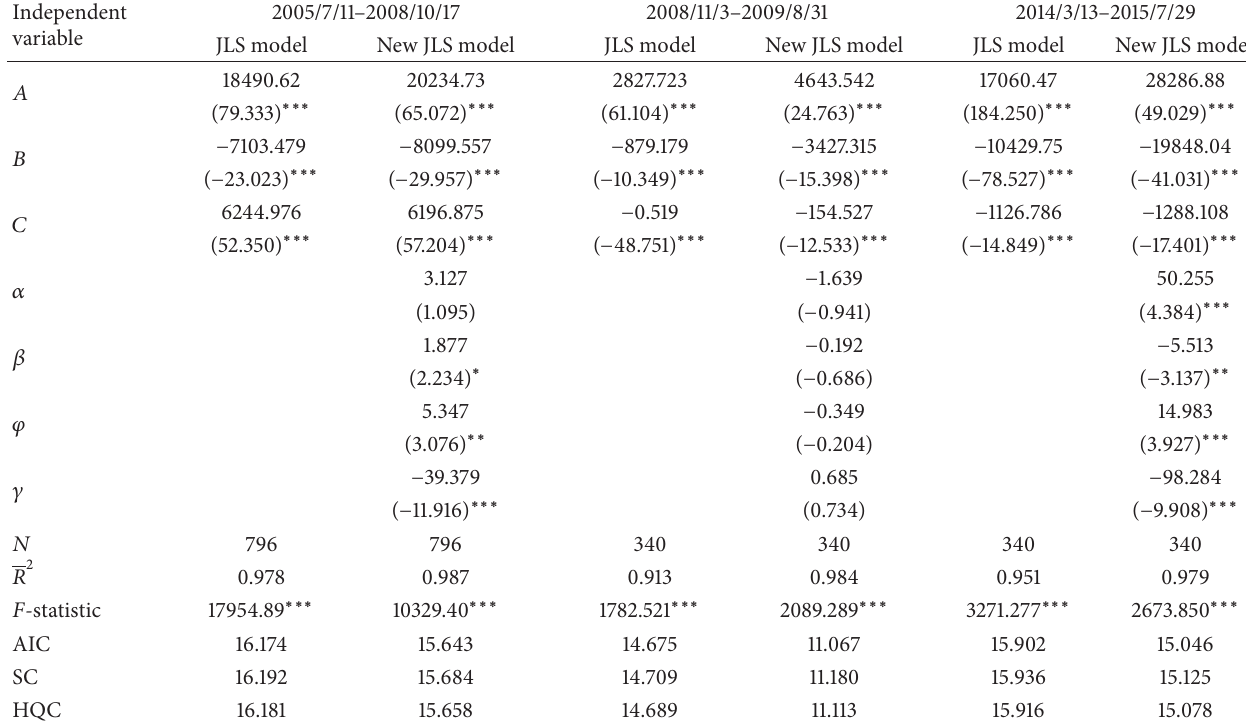
Table 6: The significance test results of the new and the original JLS model for the SZSC